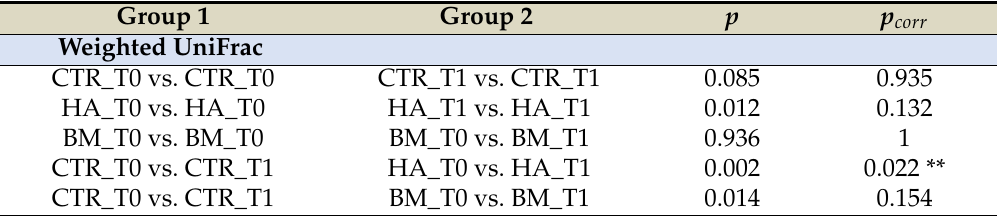
Table 3. Beta -diversity analysis based on weighted UniFrac matrix. Unweighted UniFrac is not reported for no significant comparisons. p -values are reported for the considered 11 comparisons both with and without Bonferroni correction (p corr ) . ** significant values ( p <